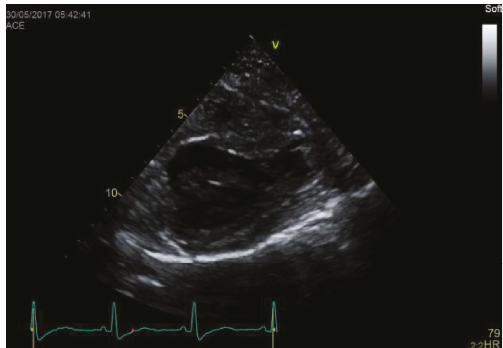
Figure 2: Parasternal short axis showing basal and apical akinesis with preserved contractility of the mid ventricular segments.